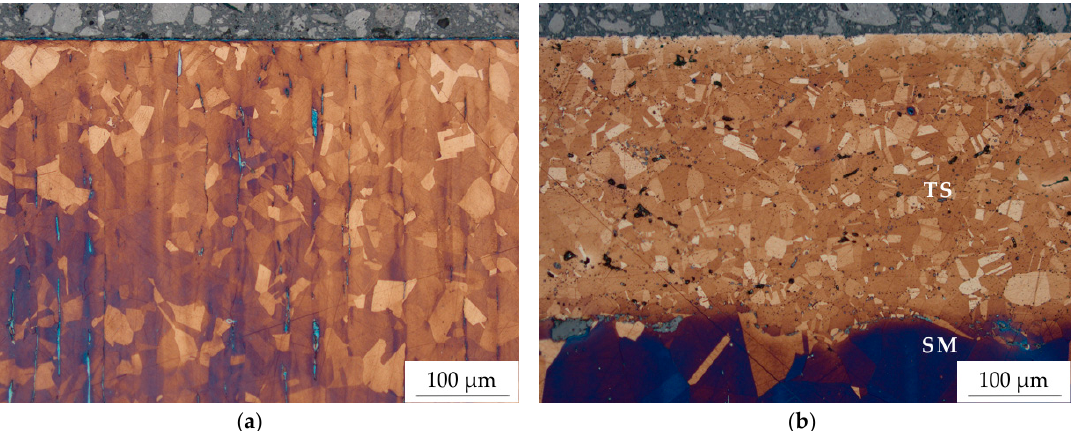
Figure 3. Optical-microscopic images of a Beraha II-etched bulk sample and the solution-heat-treated AISI 316L HVOF coating after gas nitriding 420 °C/30 h in cross-section (TS: thermally sprayed coating; SM: substrate material) ( a ) bulk sample and ( b ) solution heat treated HVOF coating.